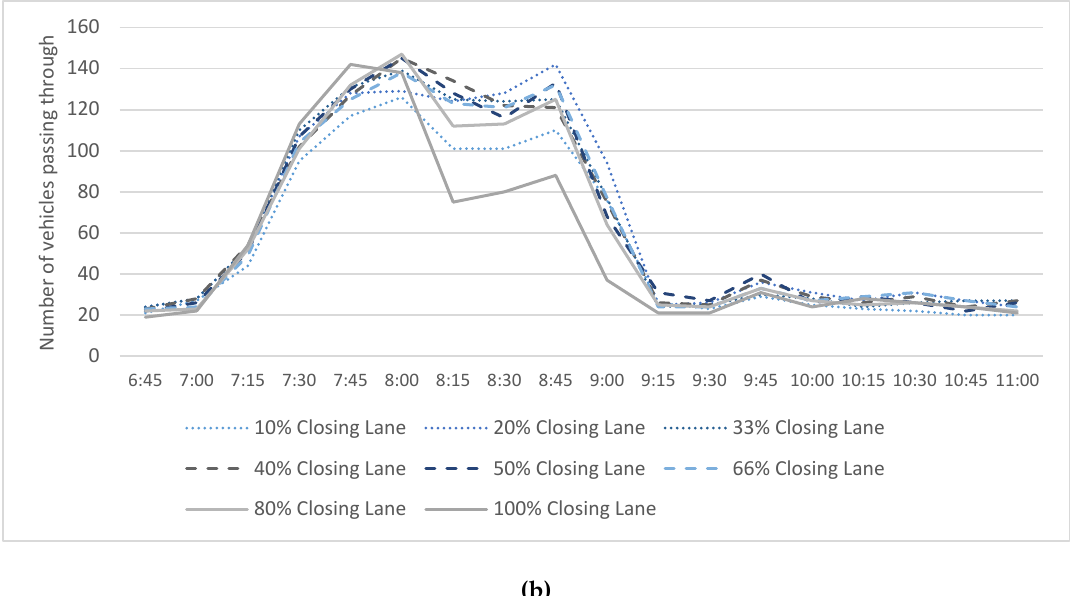
Figure 11. Traffic volumes on the open ( a ) and the closing ( b ) lanes .